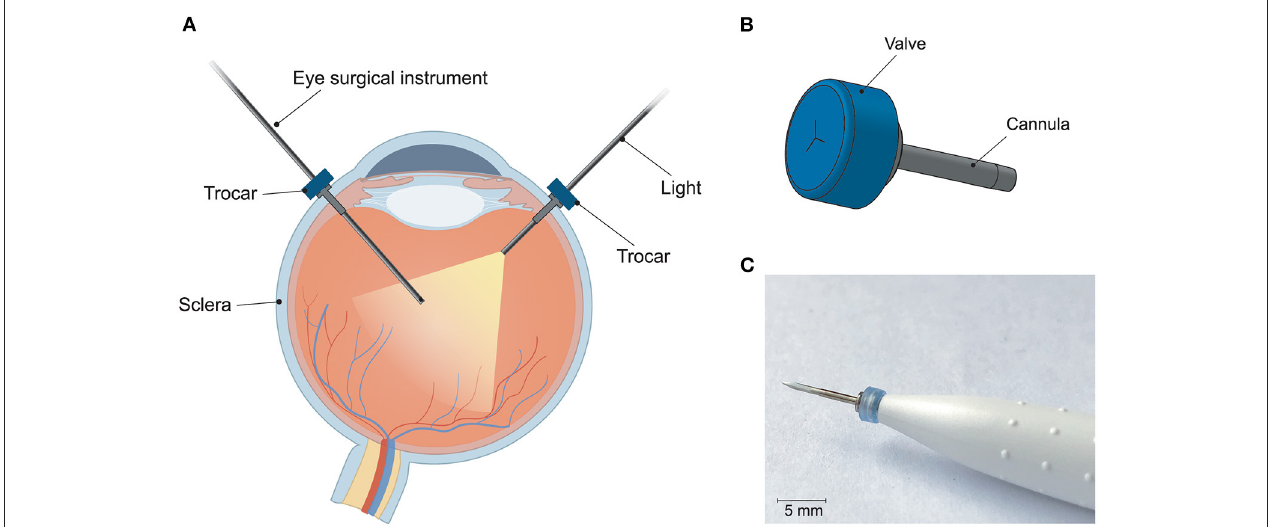
FIGURE 1 | Trocar cannula system used in eye surgery, as developed by D.O.R.C. [Dutch Ophthalmic Research Center International (Zuidland, The Netherlands)]. (A) Schematic of a cross-section of the eye with a typical set-up for eye surgery. The trocars function as a channel into the eye for surgical instruments. Only the channel of the cannula is inserted into the eye, the top part of the cannula with the valve remains outside the eye; (B) schematic illustration of a trocar consisting of a valve (blue) and cannula (gray); (C) photograph of a trocar on the inserter knife, before insertion into the